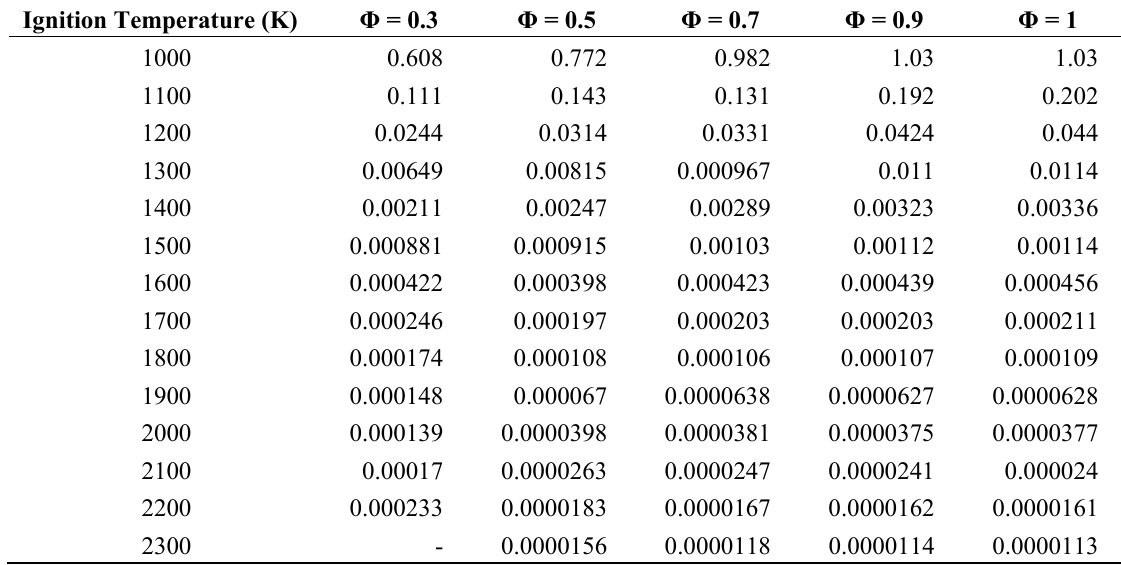
Table 3. Ignition Delay, s, 0.3 ≤ Φ ≤